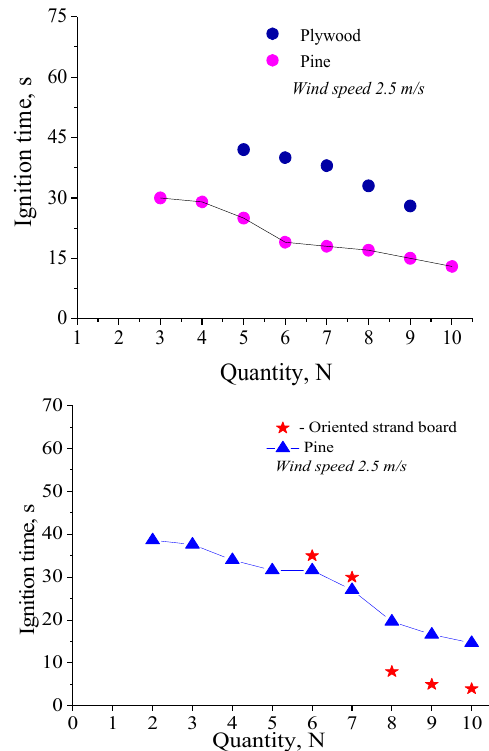
Figure 15. The ignition delay times of pine wood and construction materials.